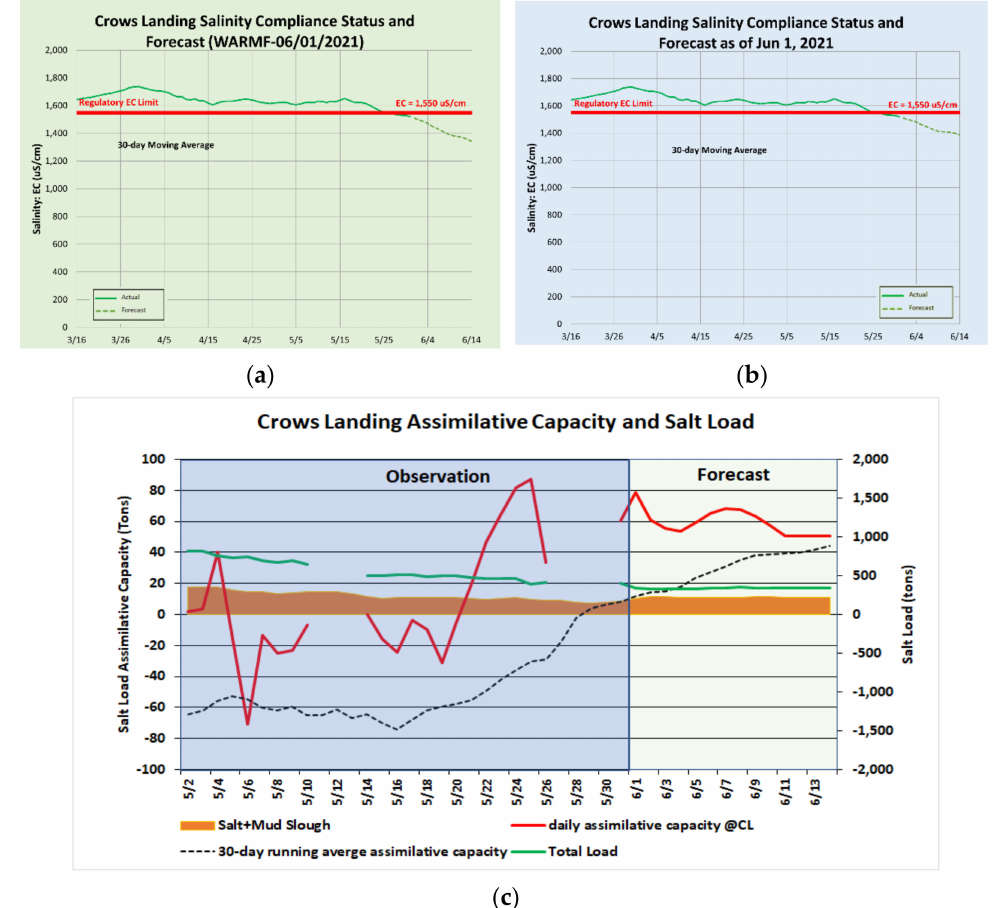
Figure 19. Comparison of daily WARMF and Regression model forecasts for EC at the Crows Landing compliance monitoring station on 1 June 2021. Figures ( a , b ) show the 30 day running average EC and forecast for 1 June 2021. Figure ( c ) shows the SLAC at the Crows landing station. By early May wetland drainage no longer dominates Mud and Salt Sloughs and daily SLAC in the river increases. The 30 day running average SLAC crosses the zero line around 28 May 2021. Breaks in the plot are the result of temporary EC sensor malfunction at the Crows Landing station. Conversion of flow in cfs to m 3 /s: 100 cfs = 2.83 m 3